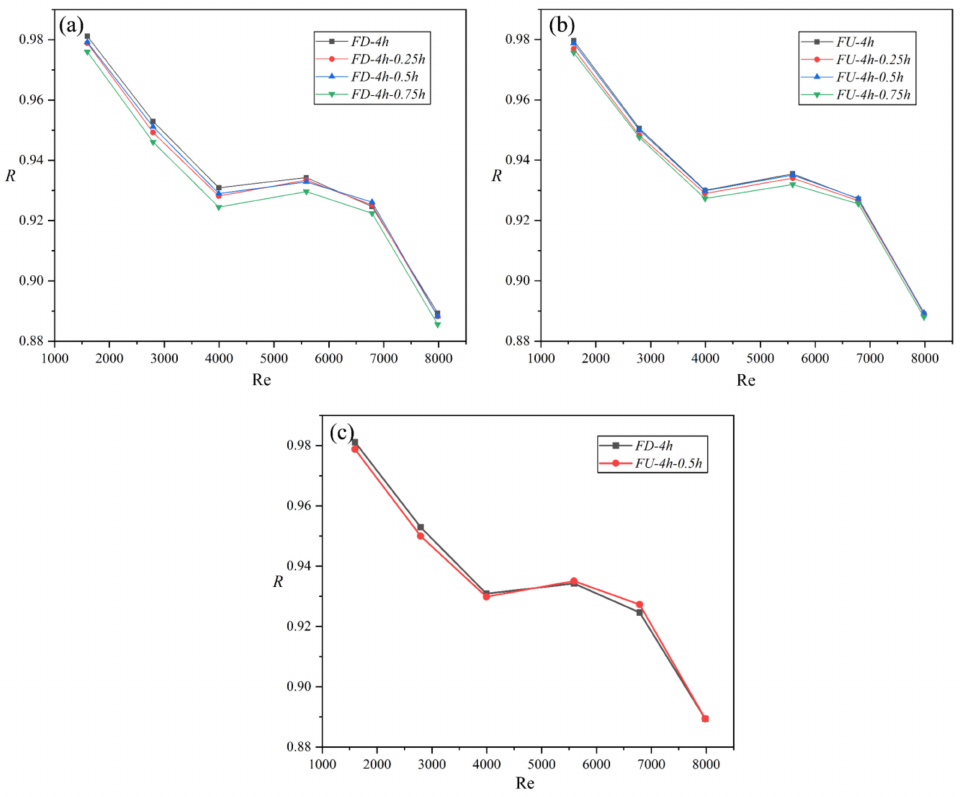
Figure 11. Performance of R at different transverse distances (0.25 h , 0.5 h , and 0.75 h ) and distribution modes, ( a ) FD-4h ; ( b ) FU-4h ; ( c ) relatively better distribution mode.